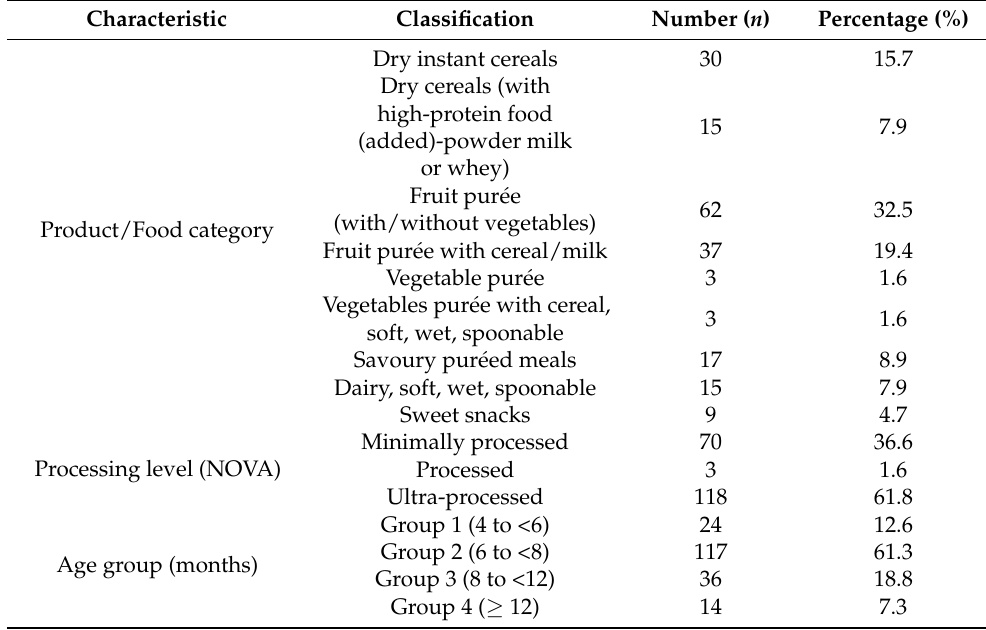
Table 1. Distribution of CACFs according to food category, processing level (NOVA), and age